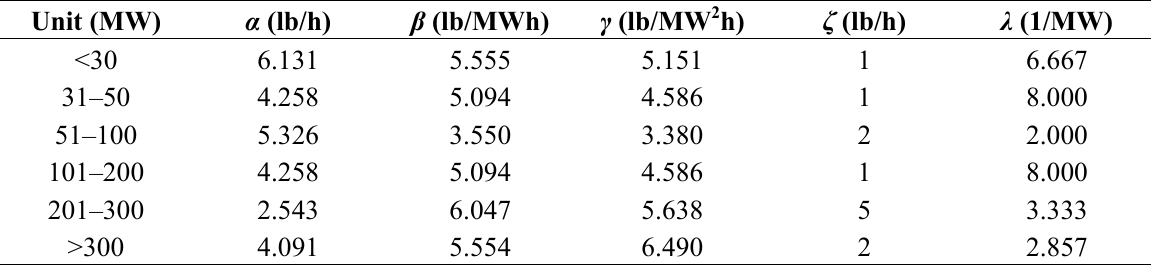
Table 1. Thermal generating unit emission coefficient